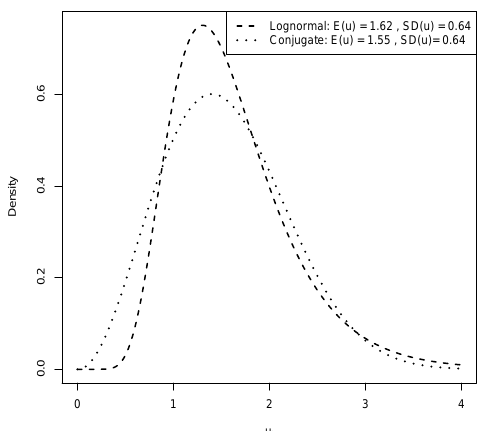
Figure 5. Lognormal and conjugate densities evaluated at ˆ θ from epilepsy